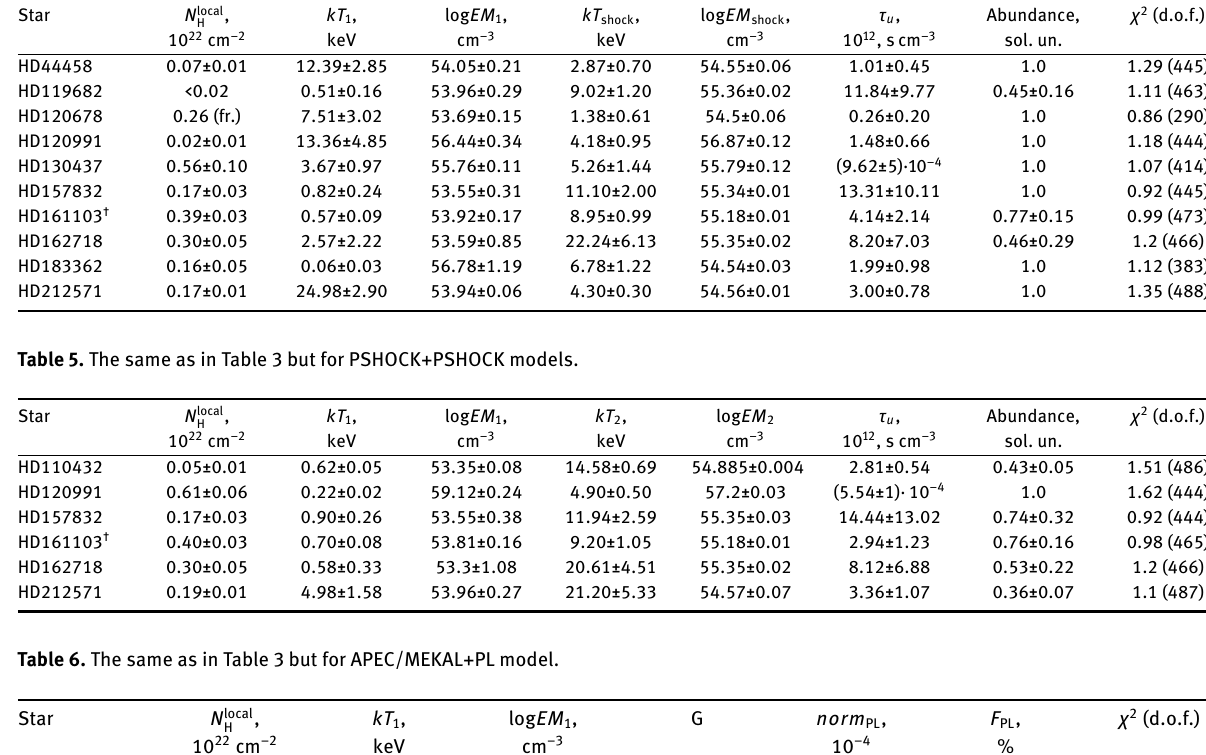
Table 4. The same as in Table 3 but for APEC/MEKAL+PSHOCK models. Star